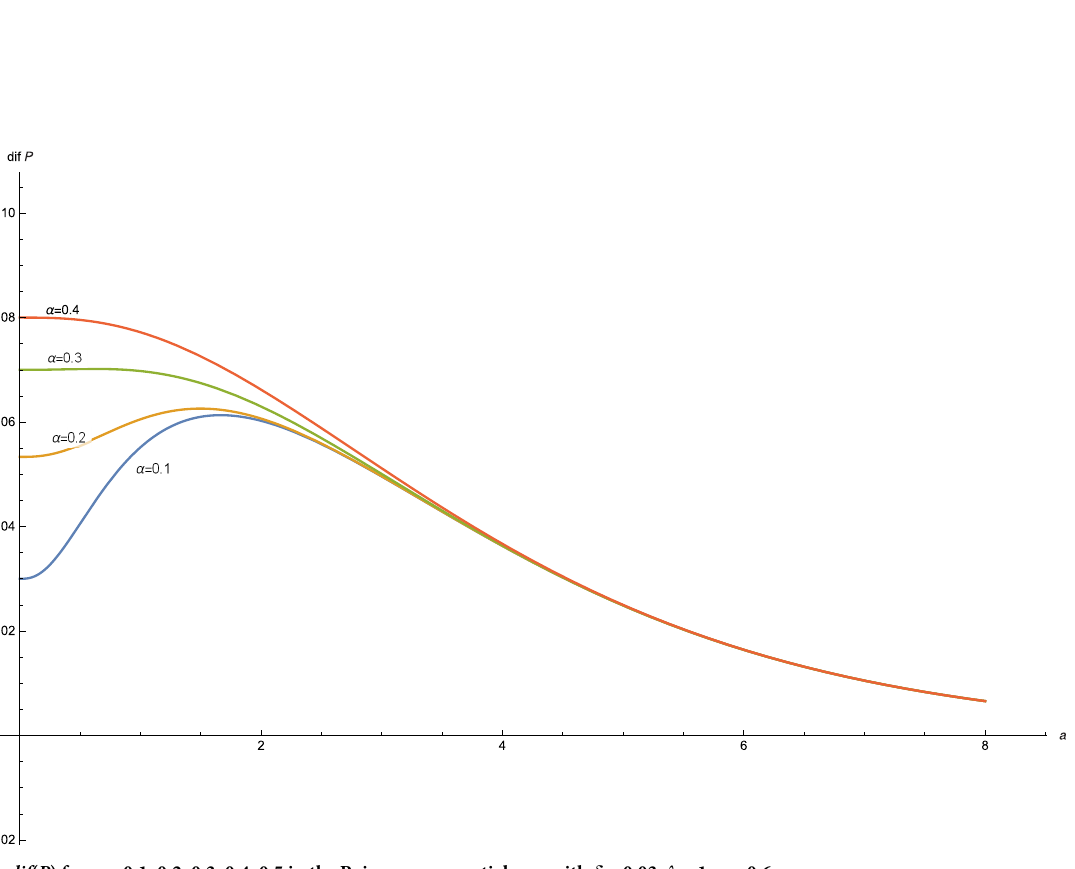
PLOS ONE | https://doi.org/10.1371/journal.pone.0247030 February 17,